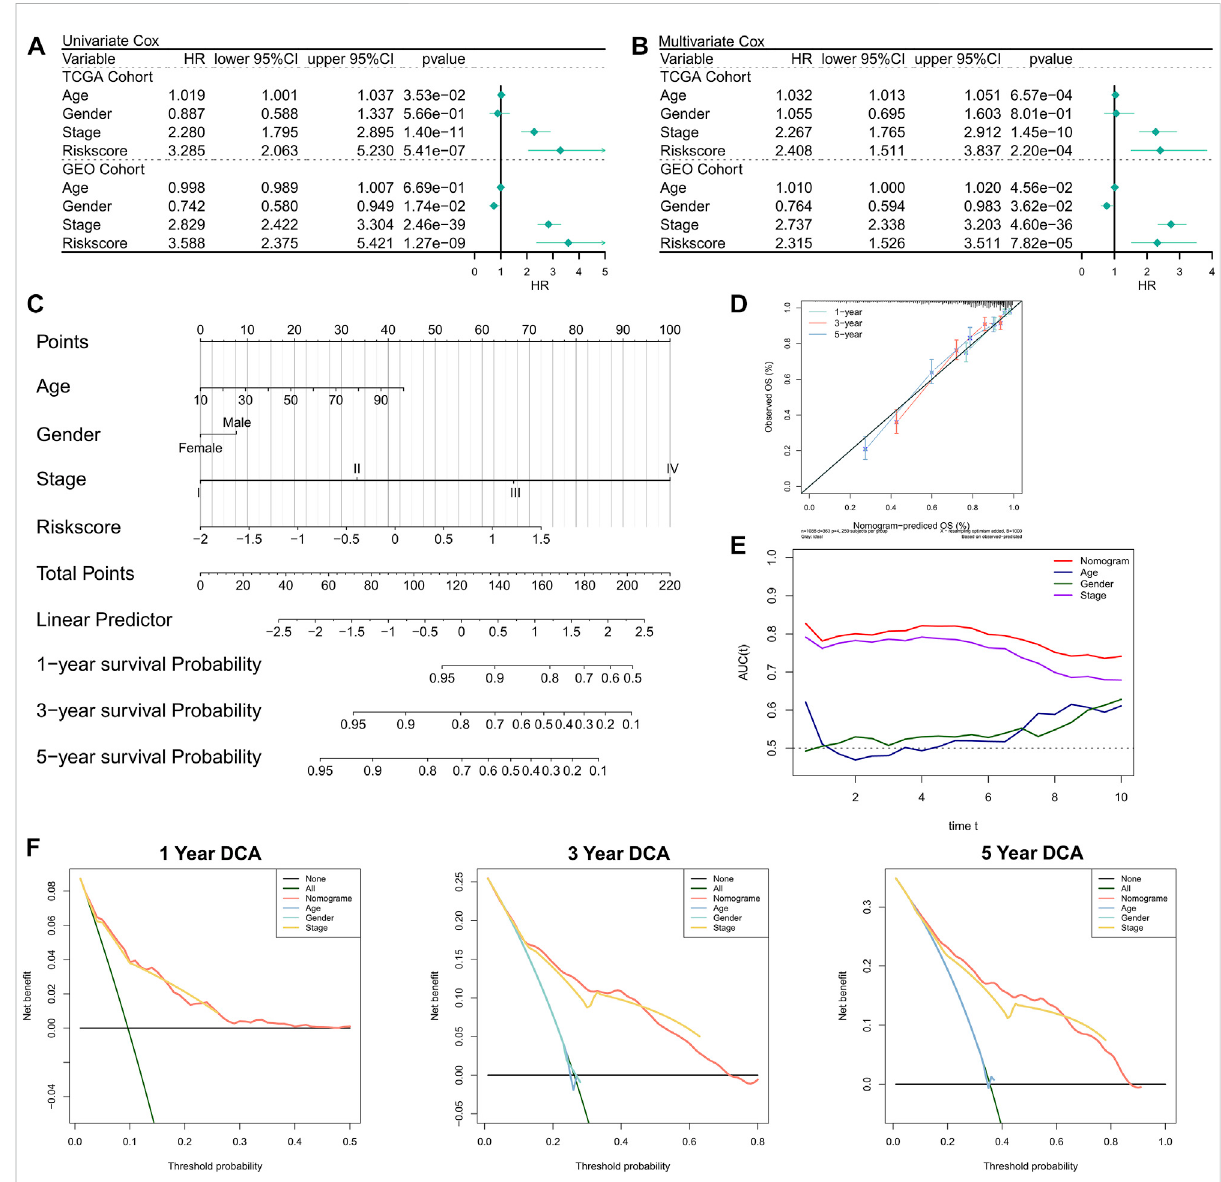
FIGURE 3 Validation of the NRG-related risk model. (A) . Univariate Cox regression analysis for OS in TCGA and GEO cohorts; (B) . Multivariate Cox regression analysis for OS in TCGA and GEO cohorts; (C) . Nomogram based on NRG-related risk model; (D) . Calibration curves for the nomogram; (E) . Clinical characteristics and tROC curves for the nomogram; (F) . 1-, 3-, and 5-years DCA curves for the